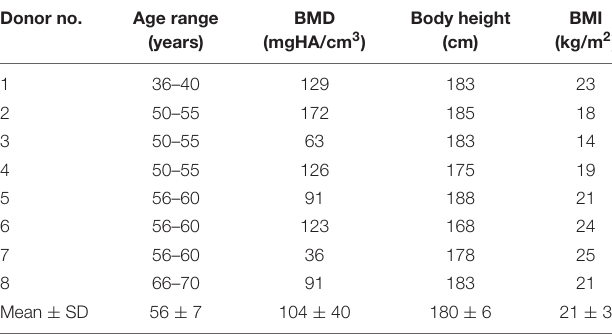
TABLE 1 | Data on donors specifying the thoracic spinal specimens which were used for the present in vitro study. Donor